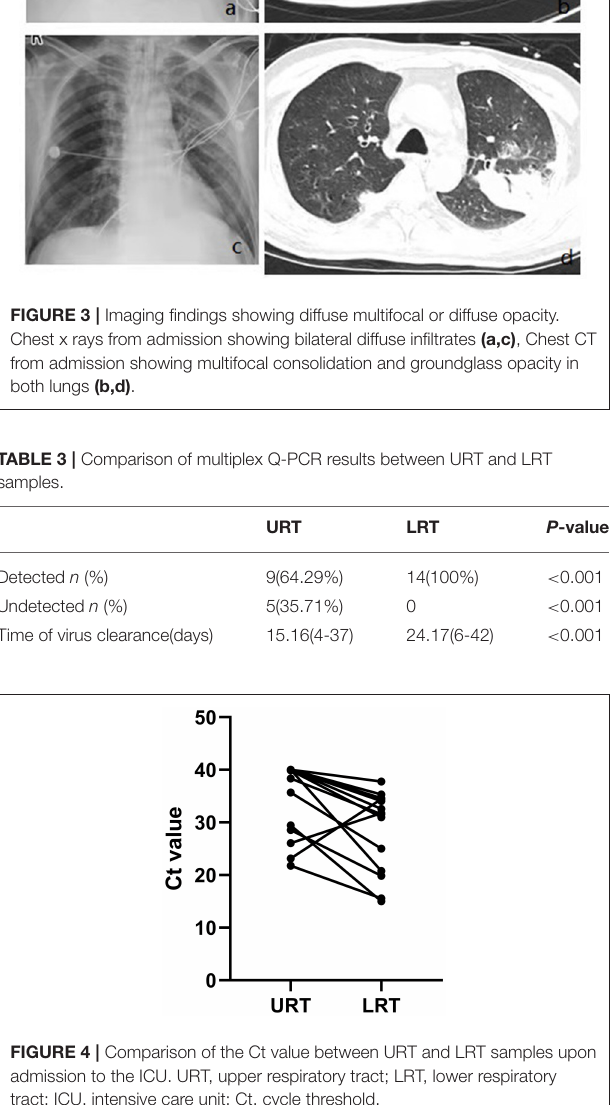
differences were detected between the two groups regarding with the